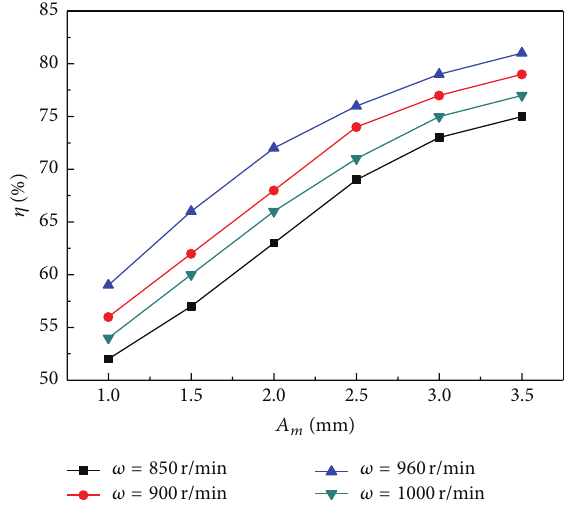
Figure 5: Effect of screen length on the sieving efficiency.